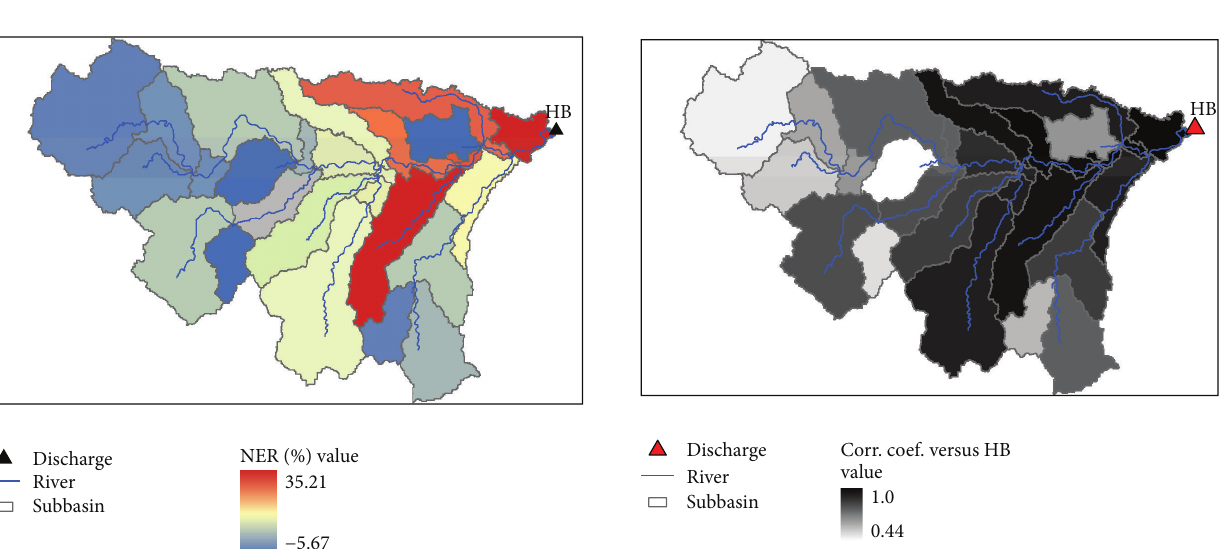
Figure 11: The NER (18) of the estimated streamflow for all subbasin outlets obtained by assimilating the streamflow observations at the catchment outlet (HB station). The NER value at the subbasin outlet is displayed on the subbasin where it is located.